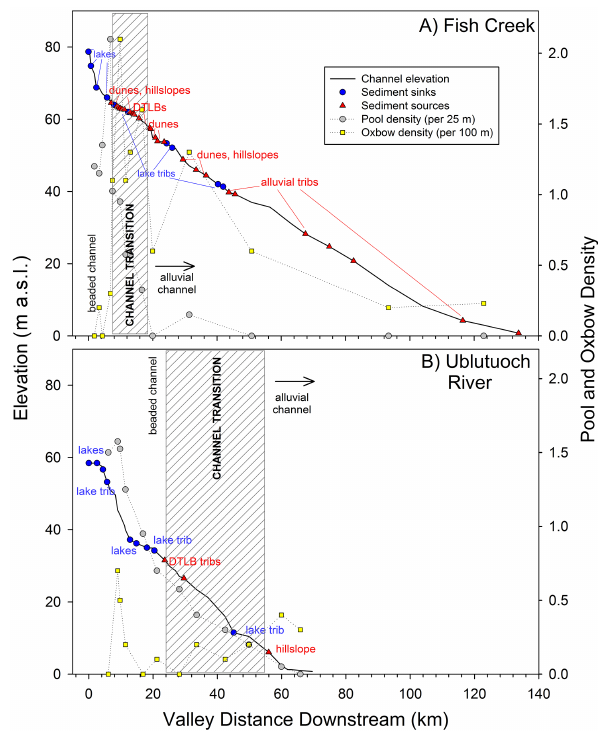
Figure 8. Headwater to downstream patterns of a beaded stream originating in the eolian sand deposits, Fish Creek (a) , compared with a beaded stream originating in alluvial–marine deposits, Ublu- tuoch River (b) , showing changes in channel elevation and the den- sity of pools and oxbow (meander-cutoff) lakes relative to sediment sources and